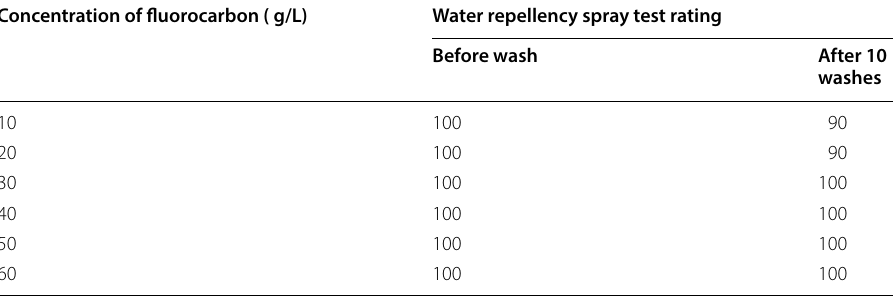
Table 1 Water repellency of cotton fabric before and after domestic laundry Concentration of fluorocarbon (